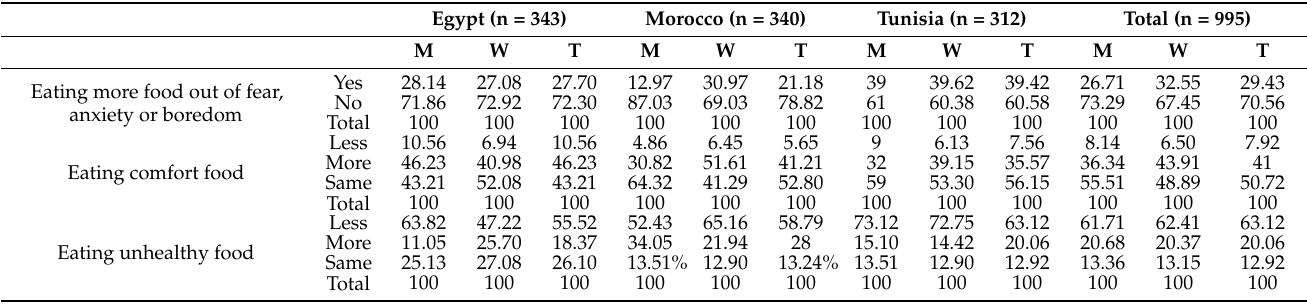
Table 2. Food eating behaviors during the COVID-19 pandemic (n = 995).